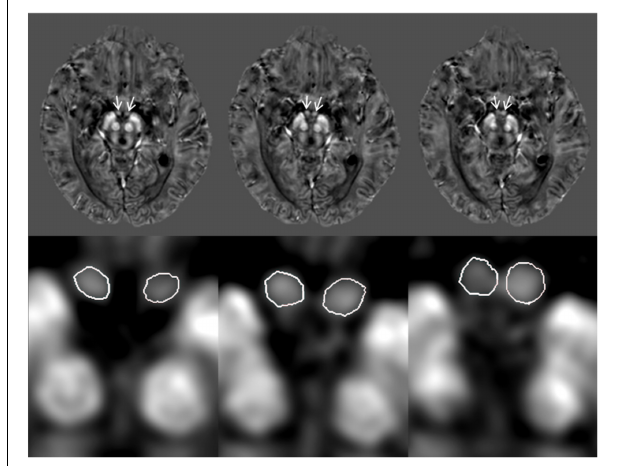
FIGURE 1 | Quantitative susceptibility maps (QSM) showing example tracings of the mammillary bodies for a subject with mild cognitive impairment (MCI). The first row: original QSM images, arrows pointing to the mammillary bodies. The second row: 8X zoom of images corresponding with the first row images showing the traced mammillary